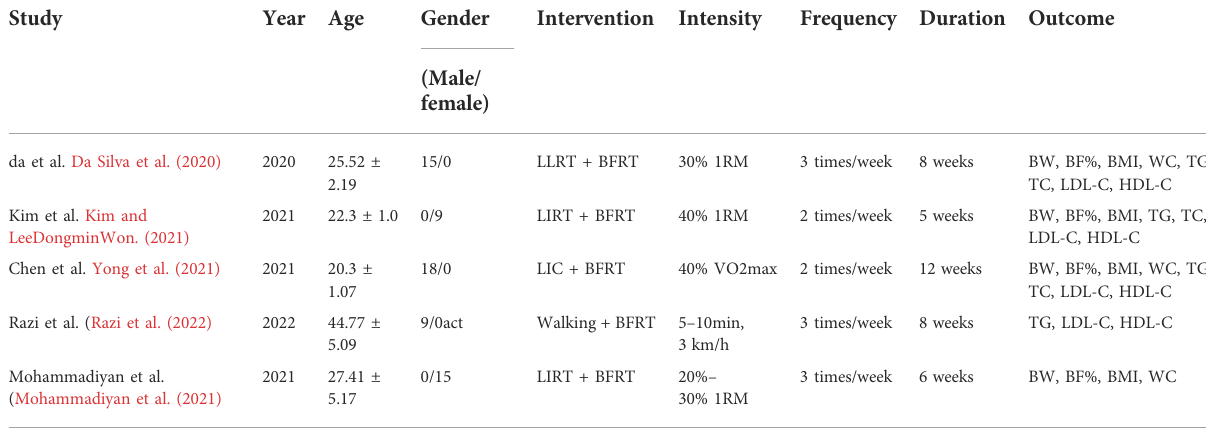
TABLE 1 Basic information of the included